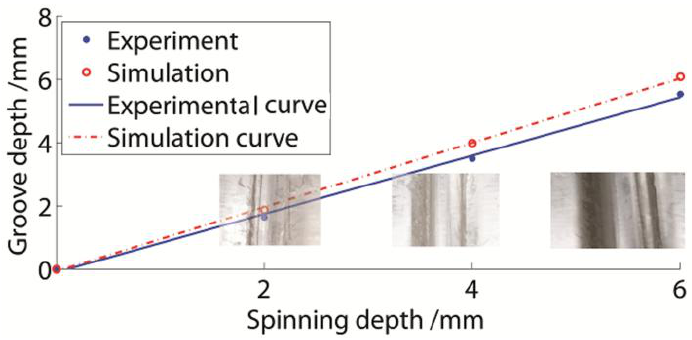
Figure 13. Groove depth variation of single-groove sheaves.